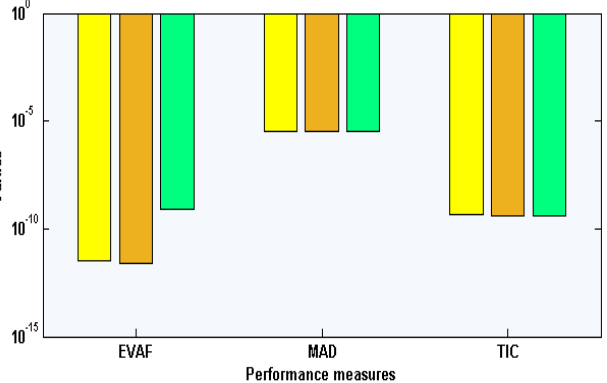
Figure 4. Performance indices through MAD, TIC, and EVAF for solving the environmental and economic nonlinear model.